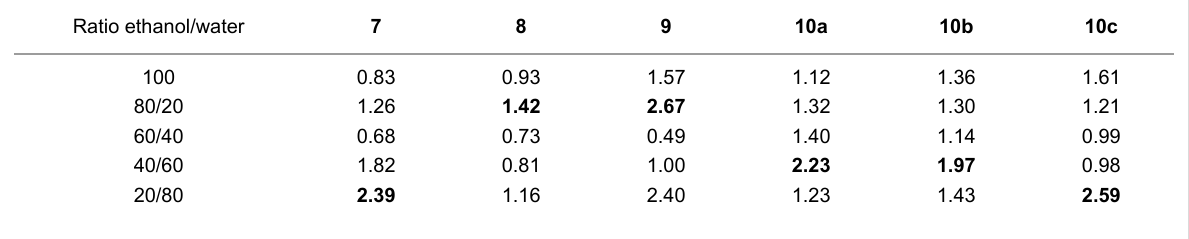
Table 5: Summarised VOC/cavity ratio (µmol/µmol) calculated for the uptake of the six VOCs on polypropylene sheets coated with the various six amphiphilic CD derivatives using five different ethanol/water ratios. The maximum values are highlighted in bold. Ratio